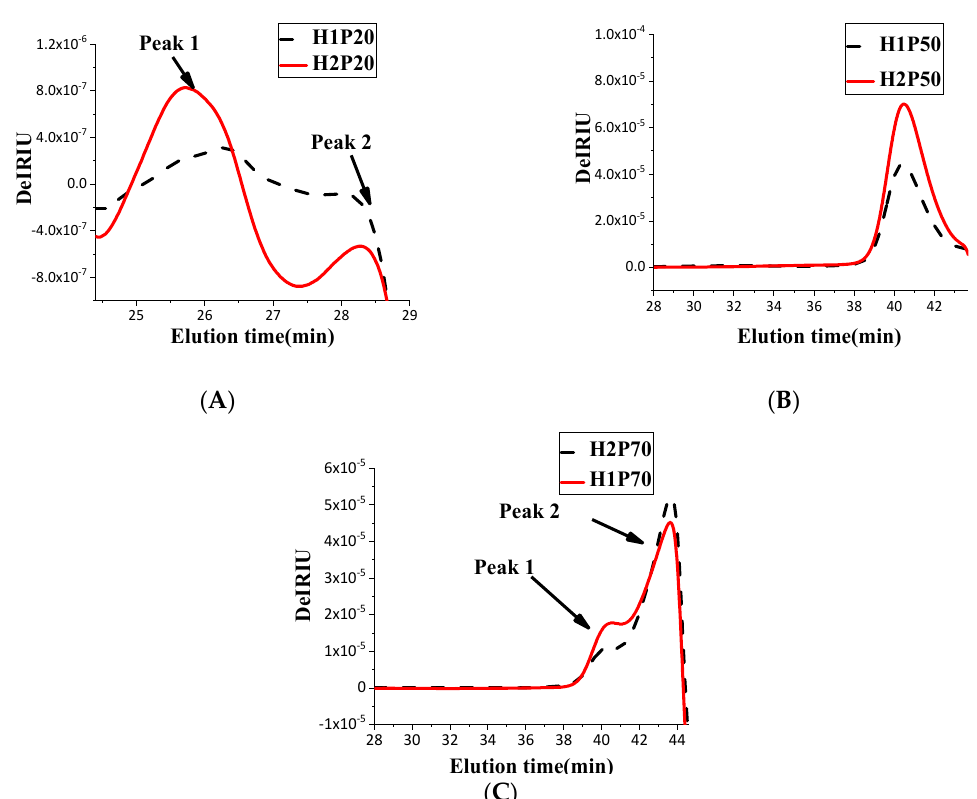
Figure 2. HPSEC-MALLS-RI (high performance size exclusion chromatography equipped with multiple angle laser light scattering and refractive index) chromatograms of 20%, 50%, and 70% ethanol precipitated polysaccharides from H. erinaceus . ( A ) HPSEC-MALLS-RI chromatograms of 20% ethanol precipitated polysaccharides; ( B ) HPSEC-MALLS-RI chromatograms of 50% ethanol precipitated polysaccharides; ( C ) HPSEC-MALLS-RI chromatograms of 70% ethanol precipitated polysaccharides; H1P and H2P represent the original and atmospheric and room temperature plasma (ARTP) mutant strain, respectively.